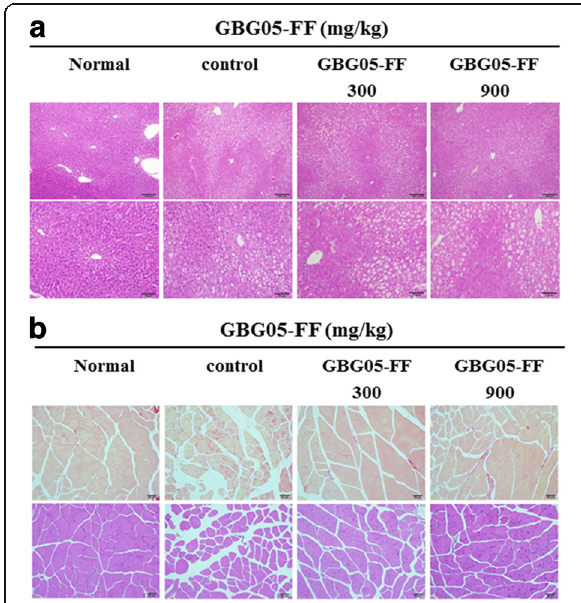
Fig. 4 Effects of GBG05-FF on histological change in liver and in muscle. The upper macrophotographs are liver magnified to 100 times their actual size, and the lower macrophotographs are liver magnified to 200 times their actual size. ( a ) Effects of GBG05-FF on histological change in muscle. The upper macrophotographs are Picrosirius red staining, and the lower macrophotographs are H & E staining ( b ). Normal: dbh, Control: db/db, GBG05-FF 300: db/db fed the GBG05-FF 300 mg/kg, and GBG05-FF 900: db/db fed the GBG05-FF 900